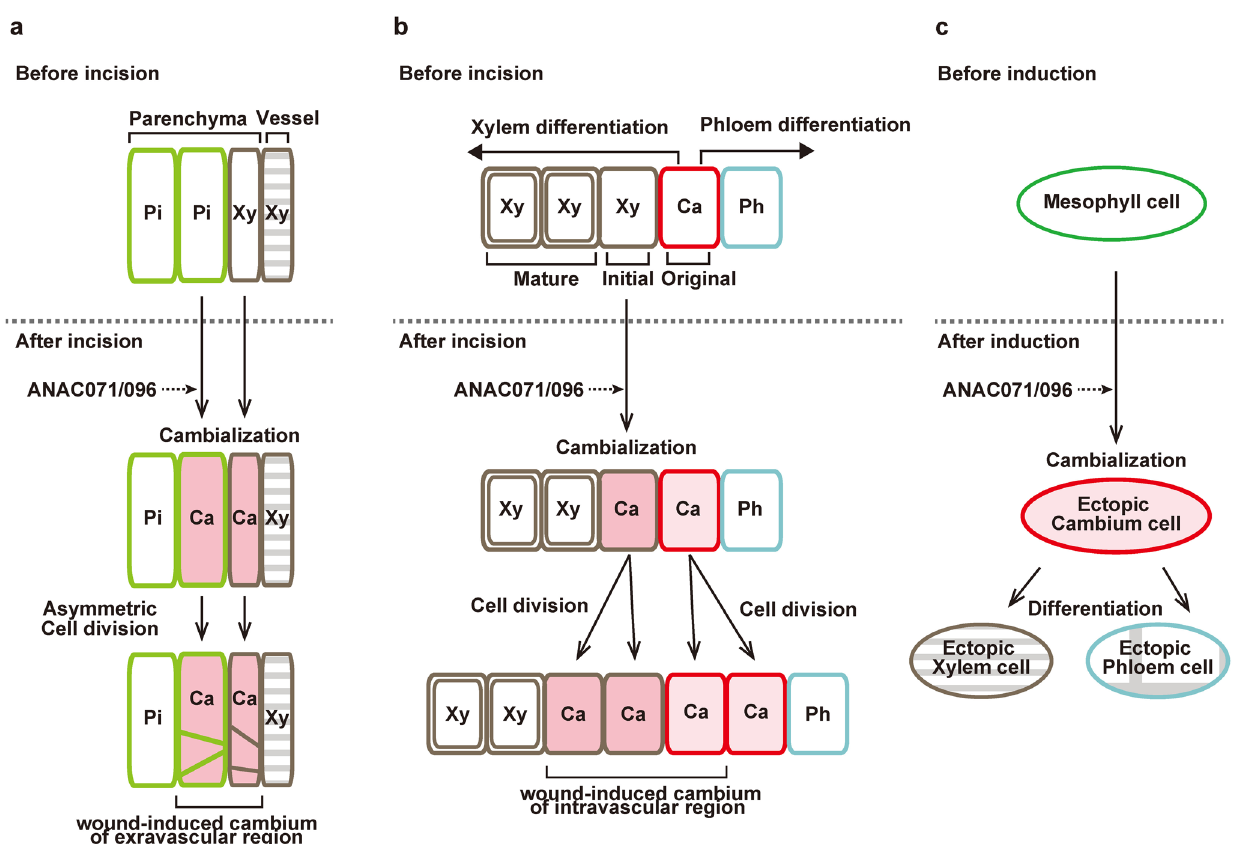
Fig. 8 Schematic model of cambialization process by ANAC071 and ANAC096. a Parenchyma cells of pith and protoxylem are converted to cambial cells around the incised site by ANAC071 and ANAC096. These cambium-like cells asymmetrically divide and become to wound-induced cambium of extravascular region. b Original vascular cambial cells divide and differentiate into xylem and phloem cells before incision. Initial xylem parenchyma cells are converted to cambial cells around the incised site by ANAC071 and ANAC 096. These cambium-like cells and original cambial cells periclinally divide and become wound-induced cambium of intravascular region. Pi pith, Xy xylem, Ca cambium, Ph phloem. c In the VISUAL assay, mesophyll cells are converted to cambial cells and then differentiate into ectopic xylem or phloem